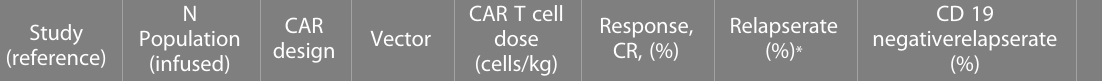
TABLE 1 Clinical outcomes after CD19 CAR T cell therapy in patients with R/R